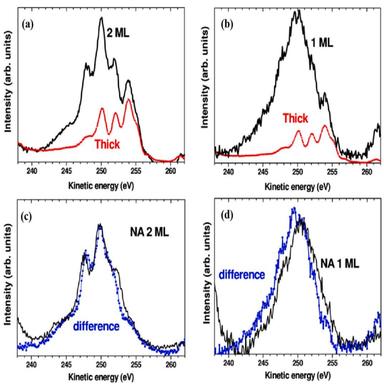
(a) The RAES of the 2 ML and the thick film samples, excited at resonance A (2p6 → 2p-1 3/23d(t2g)). (b) The difference spectrum (dotted) of the latter, compared with the NA decay spectrum of the 2 ML sample (excitation energy 310.4 eV). (c) The RAES of 1 ML and the thick film of KCl, excited at resonance A. (d) The difference spectrum (dotted) and the NA spectrum of the 1 ML sample .